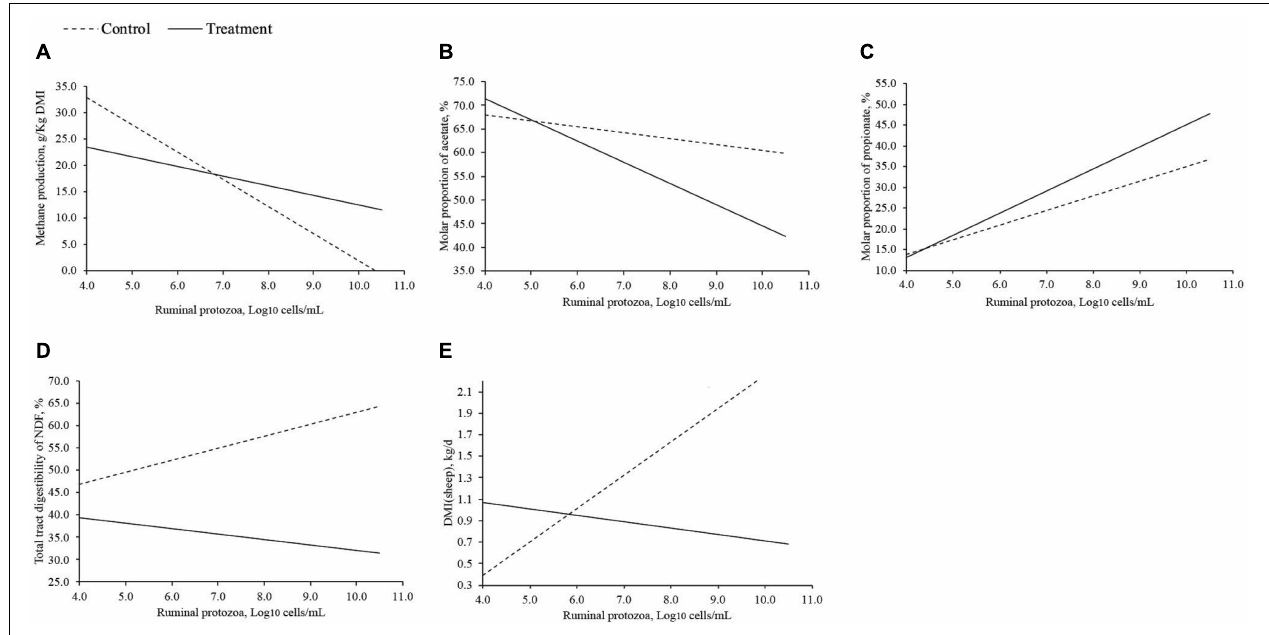
FIGURE 2 | Response of interest that significantly affected by interaction of treatment (phytochemicals and lipids) and ruminal protozoa. (A) methane production; (B) molar proportion of acetate; (C) molar proportion of propionate; (D) total tract digestibility of NDF; (E) DMI in sheep.